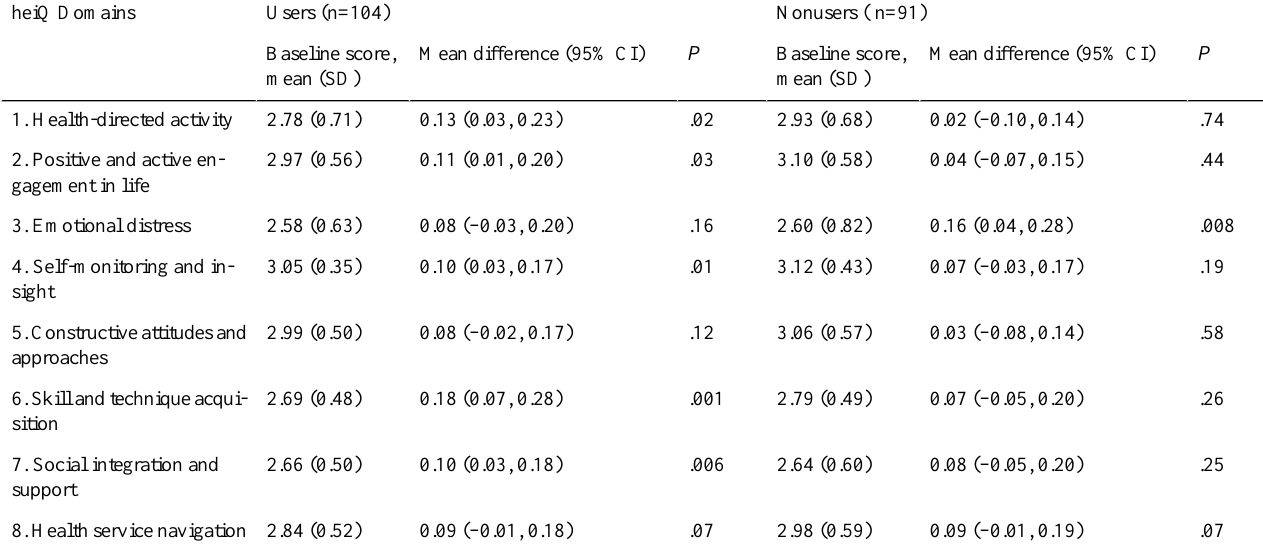
Table 2. Mean within-group change between 12-month follow-up and baseline for each Health Evaluation Impact Questionnaire domain for users and nonusers of the My Joint Pain